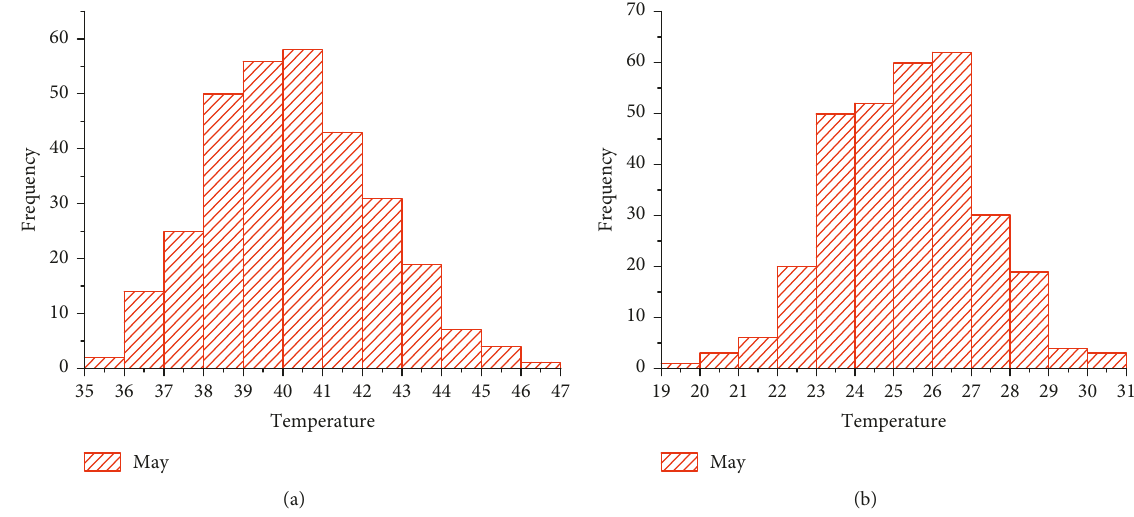
Figure 3: The histogram of the daily extreme value of axial uniform temperature in May. (a) The maximum. (b) The